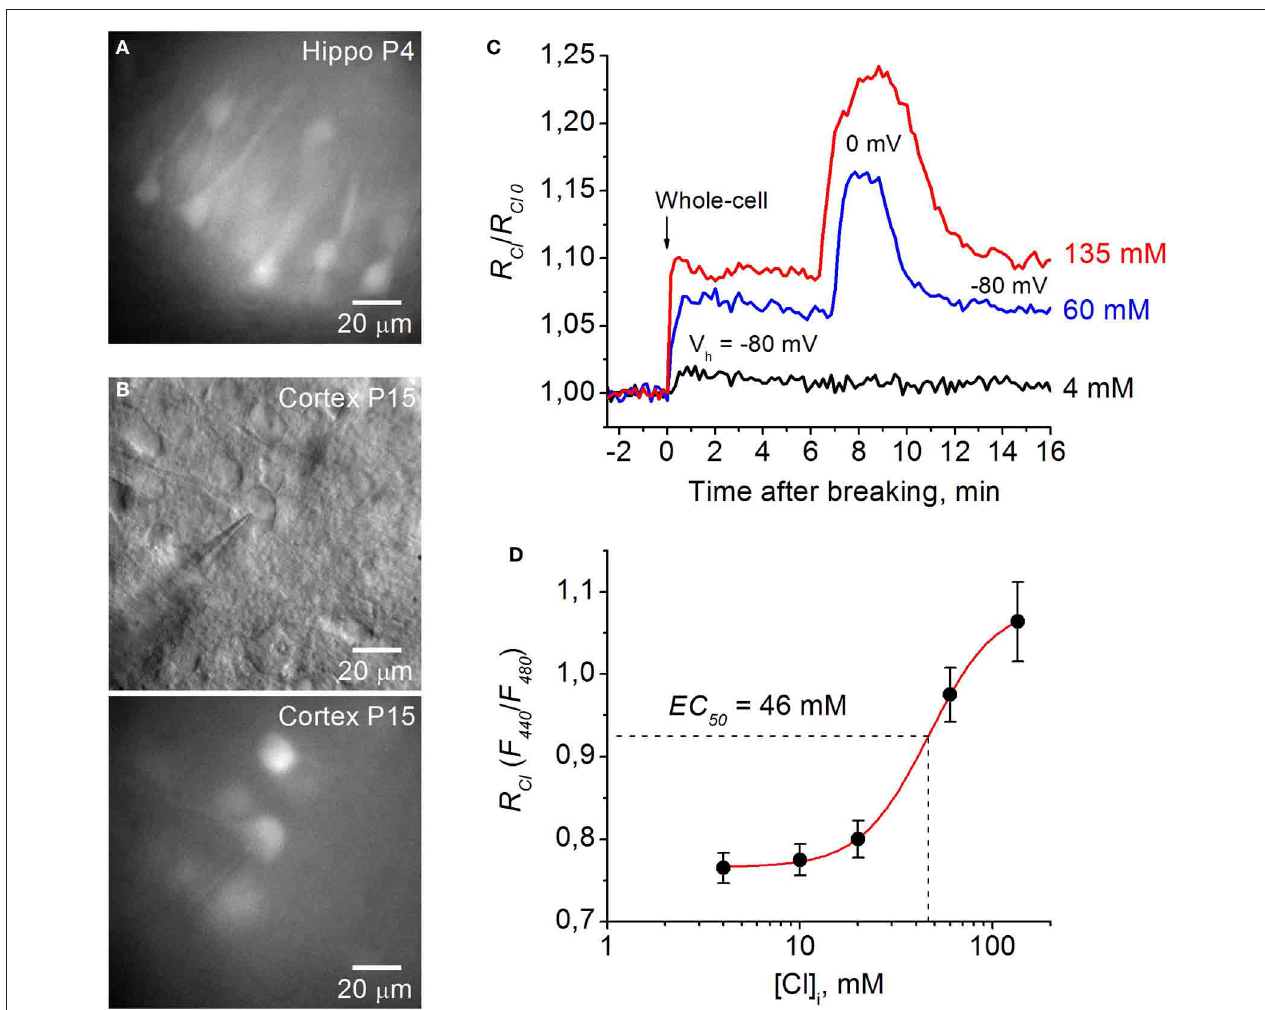
trace ). R Cl 0 corresponds to [Cl] i in cell attached mode. Time = 0 corresponds to the moment of membrane rupture into whole-cell mode. Note the further increase in R Cl at depolarization from − 80 to 0mV in the cells recorded with 60mM ( blue trace ) and 135mM ( red trace ) Cl in the pipette. (D) Calibration curve for Cl-Sensor expressed in neurons of brain slices from Thy1 mice obtained by recording at five different Cl concentrations: 4, 10, 20, 60, and 135mM. EC 50 = 46 . 4 ± 2 . 2mM (mean ± S.E.M.). Data from 5 to 7 cells for each Cl concentration are